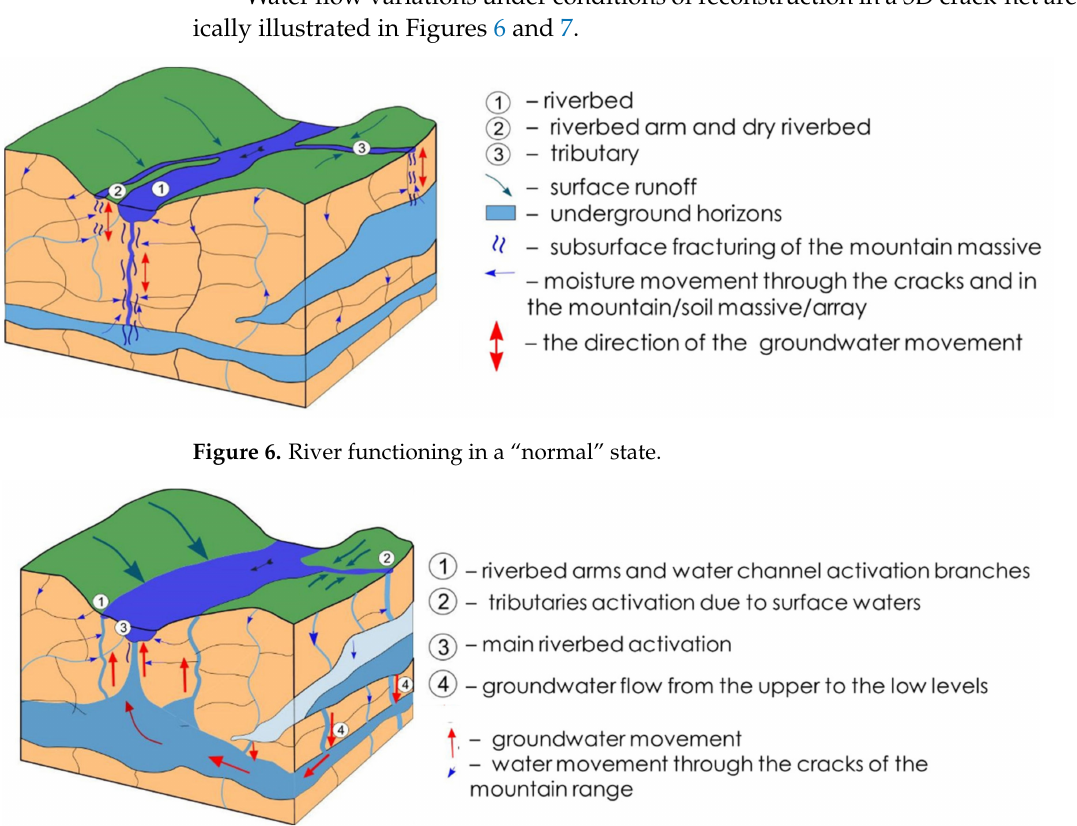
Figure 7. Reconstruction of the mountain’s massive fracturing and the river’s underground water